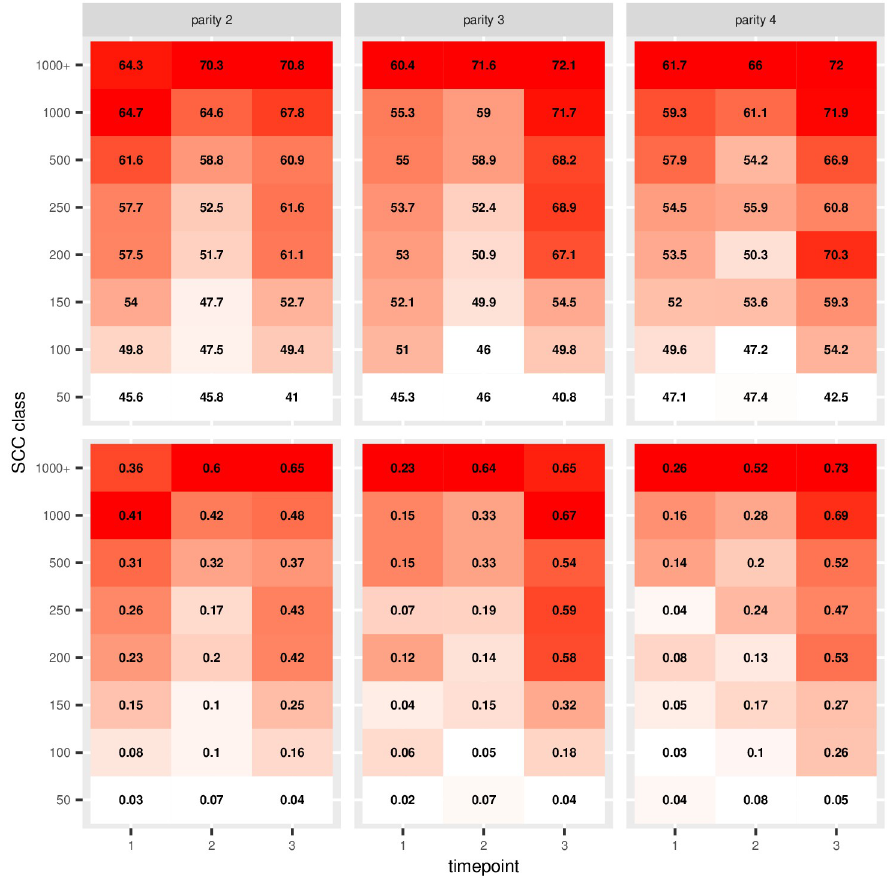
Fig 2. DSCC along SCC classes. Average DSCC per SCC class, parity and timepoint (above), and proportion of records/samples with DSCC > 70% (below). Darker colors correspond to higher values.